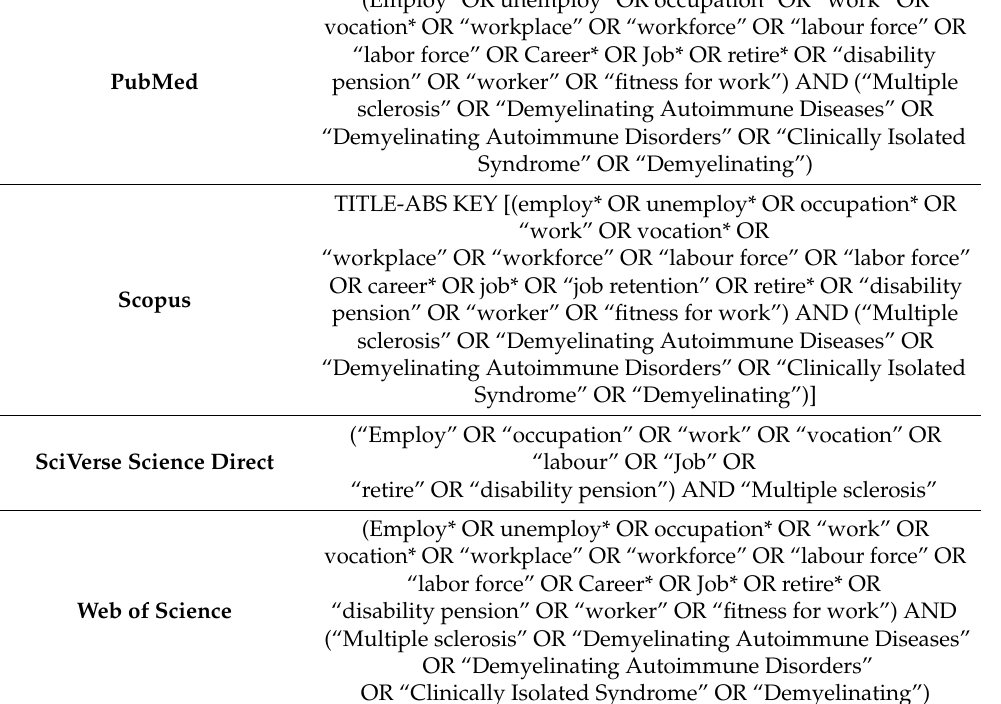
Table 1. Detailed search strategy in PubMed/MEDLINE, Scopus, SciVerse ScienceDirect, and Web of Science.